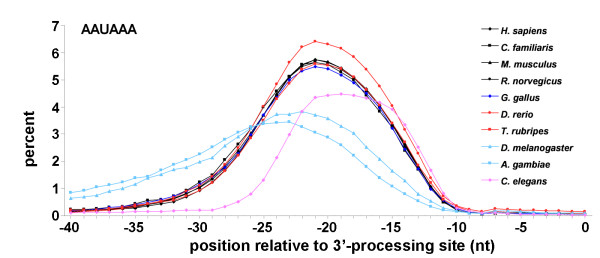
Positioning of the AAUAAA hexamer in the region upstream of the 3'-processing site for ten metazoan species.